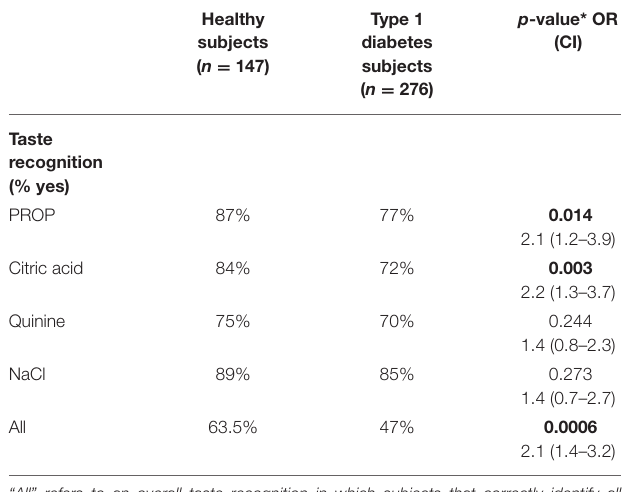
TABLE 1 | Sample characteristics of type 1 diabetes subjects and healthy subjects.